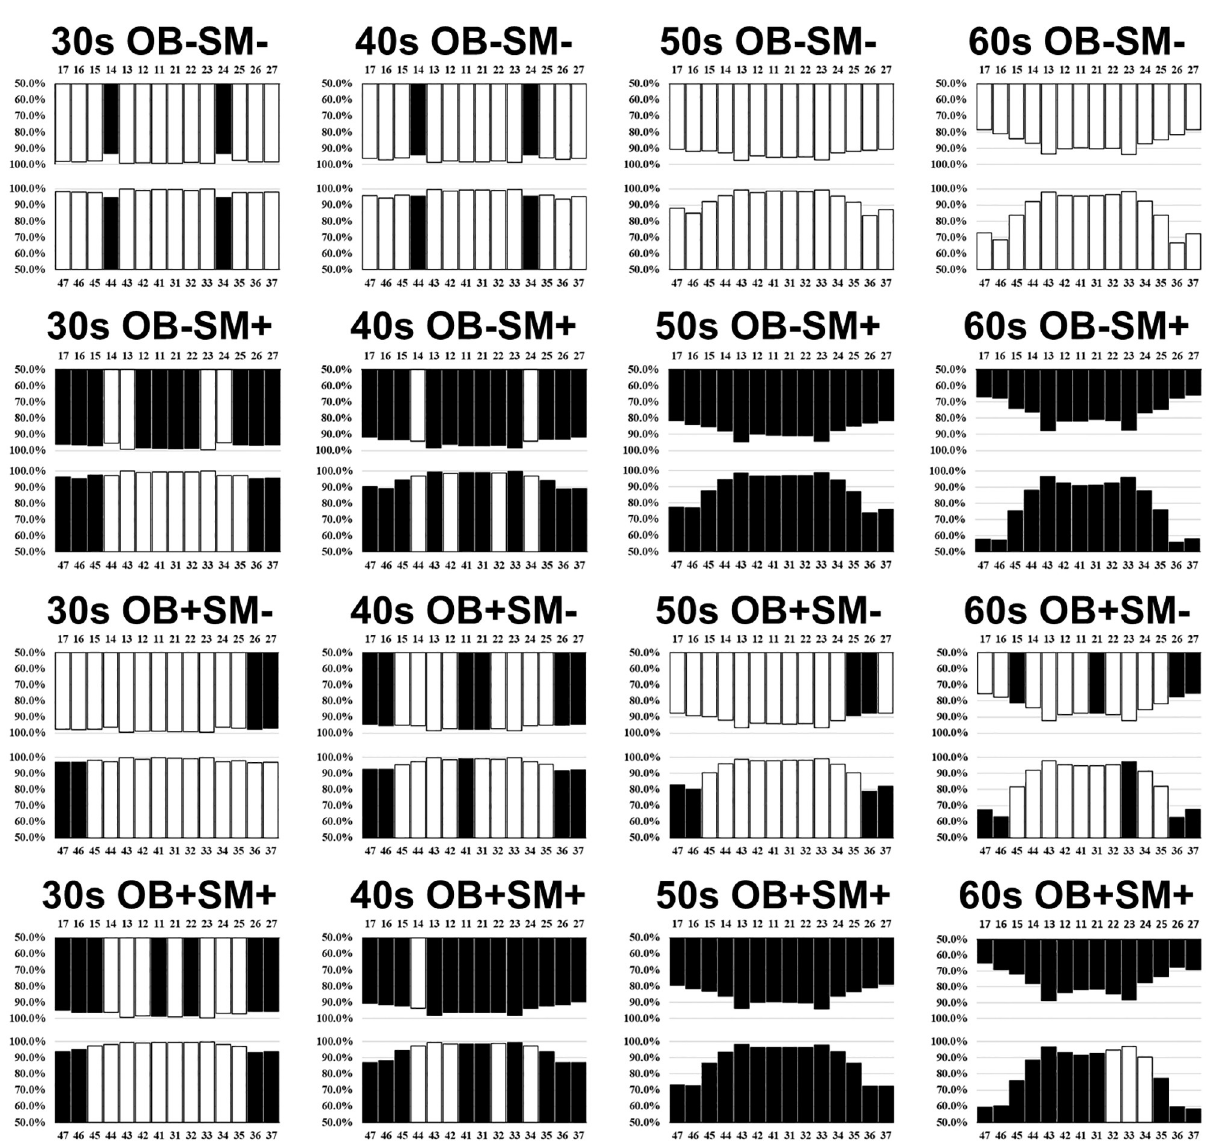
Fig 4. Percentage of obesity/ non-obesity/ smoking/ non-smoking subjects with residual teeth at each position by age groups (30s-60s). Percentage of subjects with residual teeth was calculated as the proportion of subjects that have a residual tooth at the particular position. The percentage of subjects with residual teeth was compared among the 4 groups in the same age group, and positions with a significantly lower percentage of subjects having a residual tooth than the expected value are shown in black ( p < 0.05). OB-; non-obesity, OB+; obesity SM-; non-smoking, SM+;